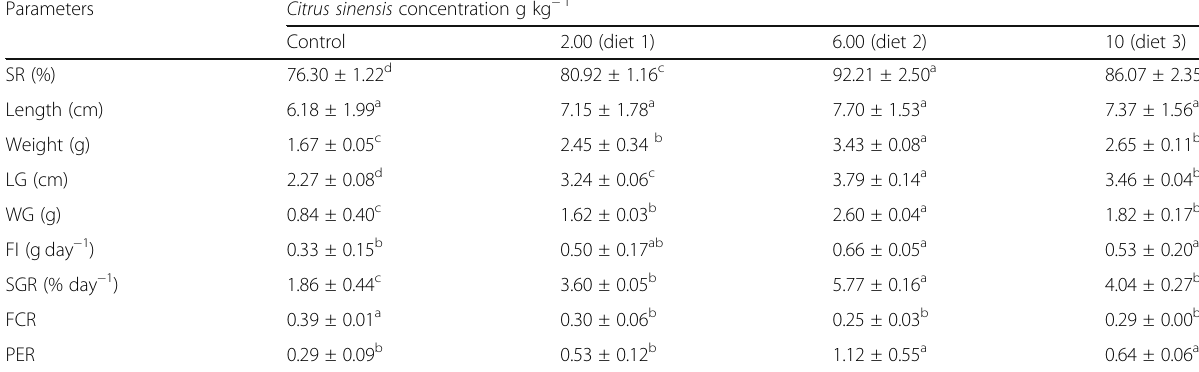
Table 2 Survival, growth, and food index evaluation of Catla catla fed with C. sinensis- supplemented diets Parameters